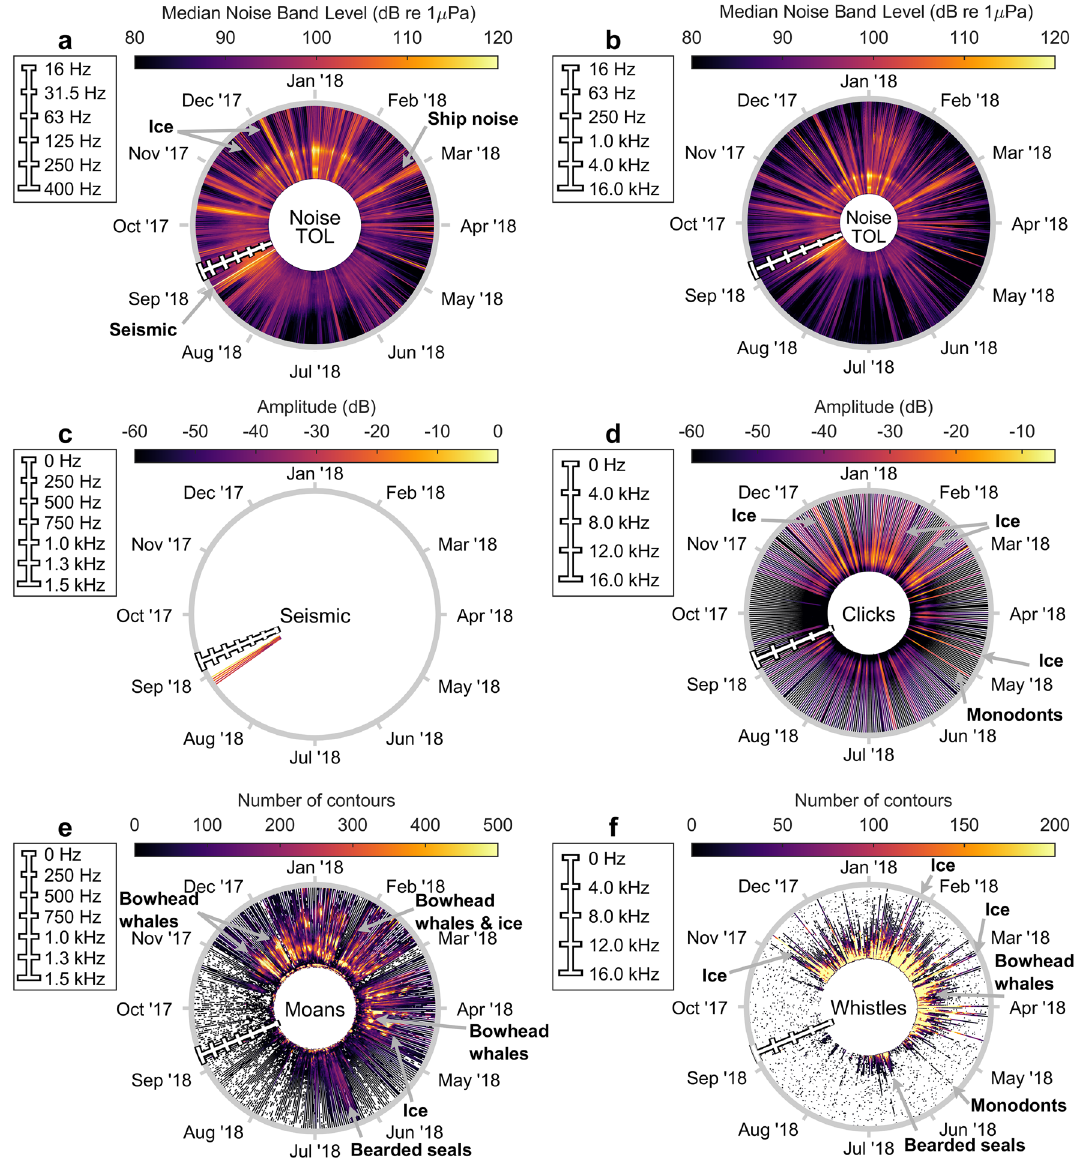
Figure 4. Example of noise and detector outputs for soundscape characterisation from station 26 plotted in 10-min resolution. Circles represent durations of 1 year. The position of the frequency scale bar in late August represents the start of the recording. ( a , b ) Daily median third octave levels (TOLs) are colour-coded relative to amplitude and shown for the third octave bands each centred at frequencies between 10 and 400 Hz ( a ) and over the full range from 10 Hz to 12.5 kHz ( b ) on a logarithmic axis. ( c ) Seismic survey detections are shown as the median frequency content (< 1.5 kHz) of the detected events. ( d ) The median spectral content for all transients detected. ( e ) The contours for all detected low-frequency tonal signals (moans, < 1500 Hz) are plotted on top of each other and colour-coded as number of signals overlapping in each frequency bin (5.86 Hz width). ( f ) The contours for all detected high-frequency tonal signals (whistles, 1500–16,384 Hz) are plotted on top of each other and colour-coded as number of signals overlapping in each frequency bin (32 Hz